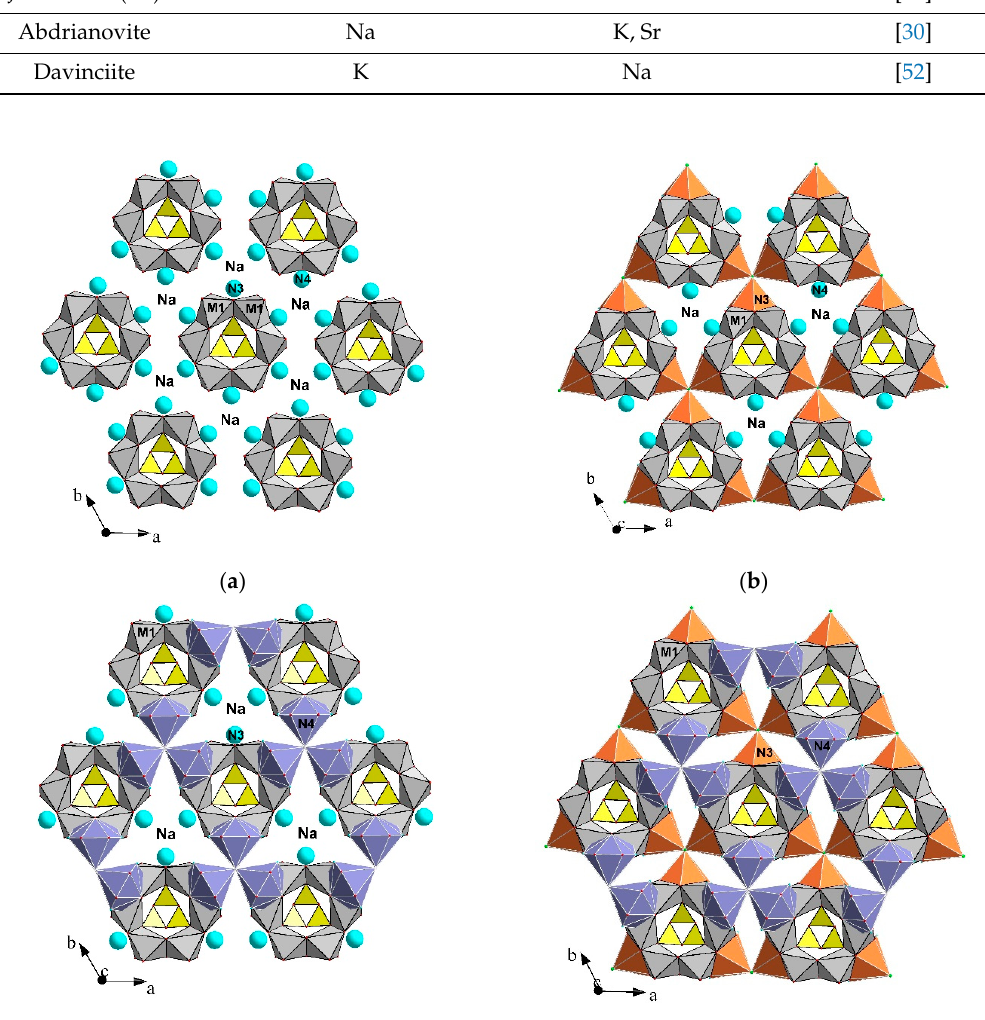
Figure 12. Layers consisting of M 1 Са -, N 3 Na-, and N 4 Na-polyhedra in Na-rich EGMs ( a ); M 1 Ca-, N 3 Ca-, and N 4 Na-polyhedra in feklichevite ( b ); M 1 Ca-, N 3 N а -, and N 4 Ca-polyhedra in golyshevite ( c ); and N 3 Ca-, and N 4 Na-polyhedra in feklichevite ( b ); M 1 Ca-, N 3 Na-, and N 4 Ca-polyhedra in golyshevite ( c М 1 Ca-, N 3 Ca-, and N 4 Ca-polyhedra in mogovidite ( d ).